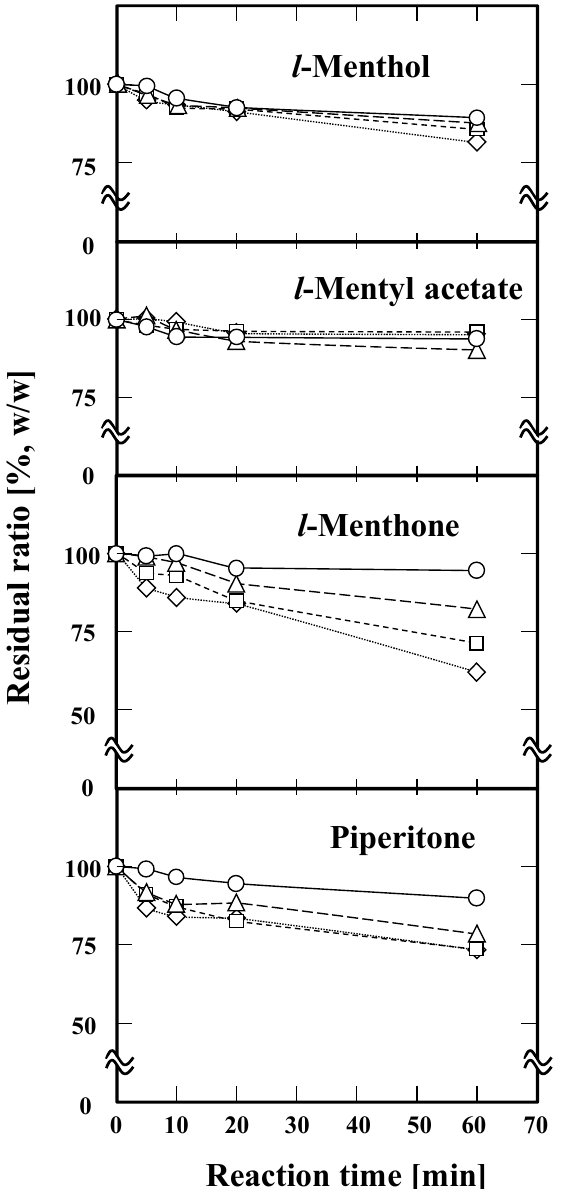
Figure 1. Subcritical water treatments of the mixture containing l -menthol, l -menthyl acetate, l -menthone, and piperitone. The subcritical water treatments were carried out at 180 °C ( 〇 ), 200 °C ( △ ), 220 °C ( □ ), and 240 °C ( ◇ ). The reaction time was carried out for 5, 10, 20, and 60 min, respectively.